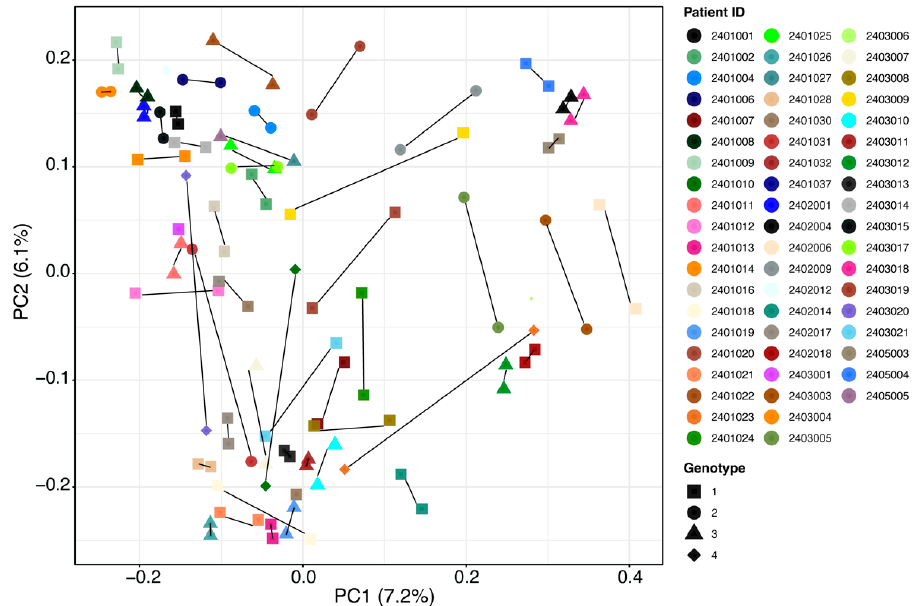
Figure 3. Overall beta-diversity differences before treatment (baseline) vs. SVR12 groups by pa- tient and HCV genotype. Notable outliers with considerable changes are circled in red. Examples of minimal change are circled in blue for comparison. Non-parametric analysis of variance (Adonis) was used to test significant differences between groups on the PCoA (principal coordinate analysis) plot with a result of p > 0.05. SVR12 = sustained virologic response 12 weeks after the end of treatment.